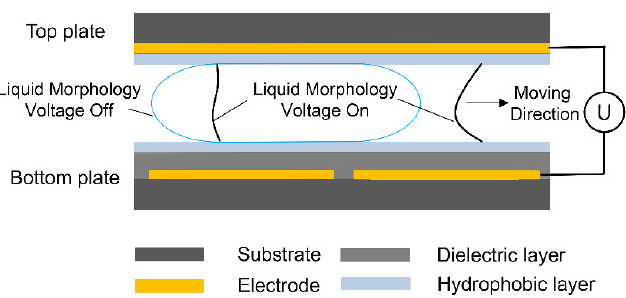
Figure 1. Schematic for electrowetting-on-dielectric (EWOD) principle. The light blue line demon- strates the droplet shape without applied voltages. The black line shows the droplet shape with the applied voltage. The applied voltage drives the liquid to the position of the actuated electrode.